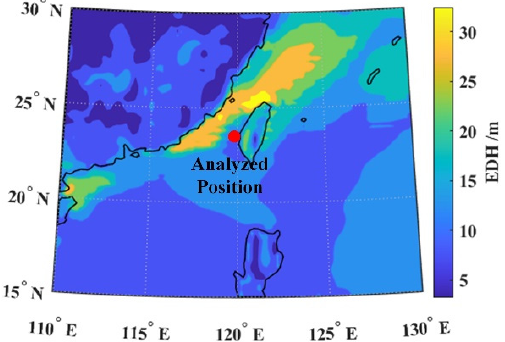
Figure 3. The average EDH in the Taiwan Strait during July 2020. Monthly and hourly statistical results of the EDH at a typical position (23.4 ◦ N, 120.0 ◦ E) of the Taiwan Strait are shown in Figures 4 and 5, respectively. To analyze the pattern of the EDH variation with the alternation of day and night, we used local time (Beijing time) instead of Universal Time Coordinated (UTC). From 9 to 14 o’clock, the percentage of the EDH exceeding 10 m was significantly higher than in other periods,